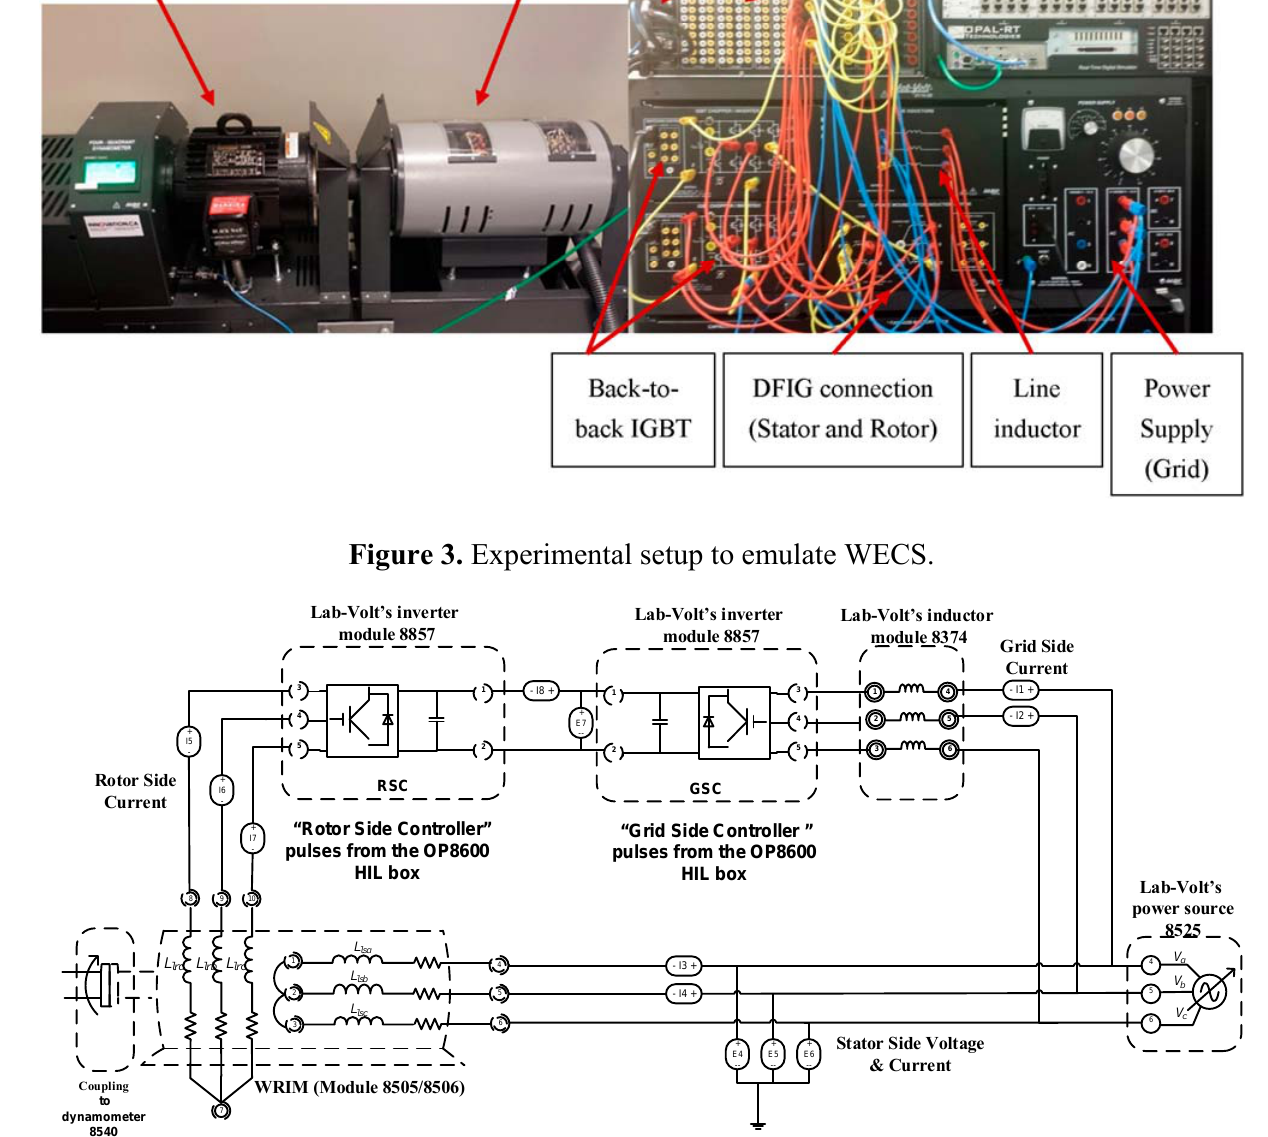
Figure 4. Schematic of the connected experimental setup to emulate